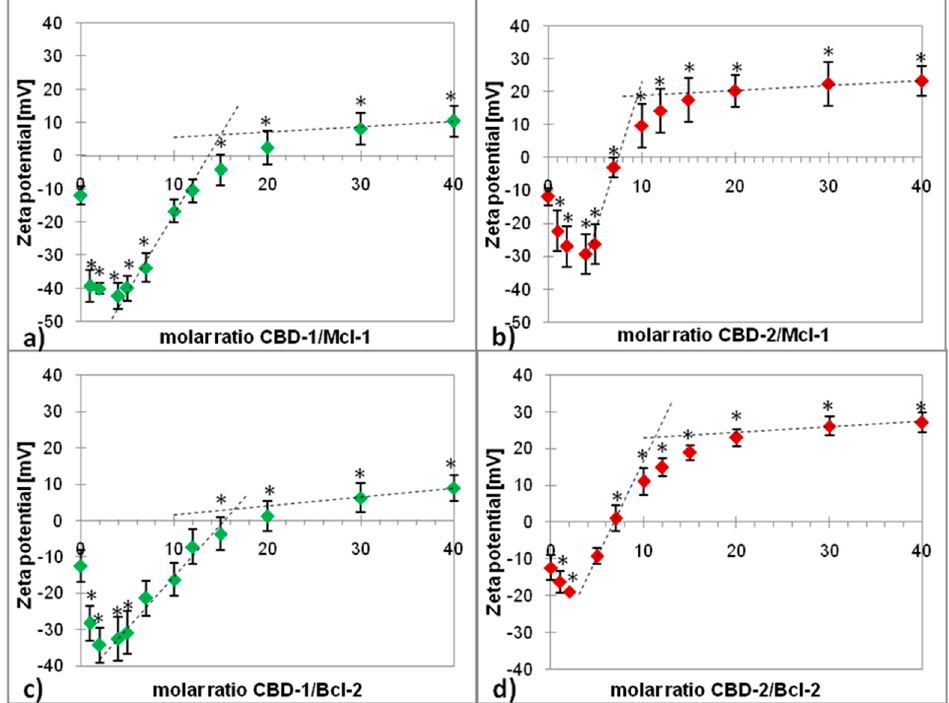
Figure 1. Zeta potential of the Mcl-1 ( a , b ) and Bcl-2 ( c , d ) after addition of carbosilane dendrimers CBD-1 or CBD-2 at increasing dendrimer/siRNA molar ratios in 10 mmol/L Na-phosphate buffer, pH 7.4. Results are presented as mean ± SD from a minimum of 3 independent experiments. * p < 0.05 compared to siRNA.